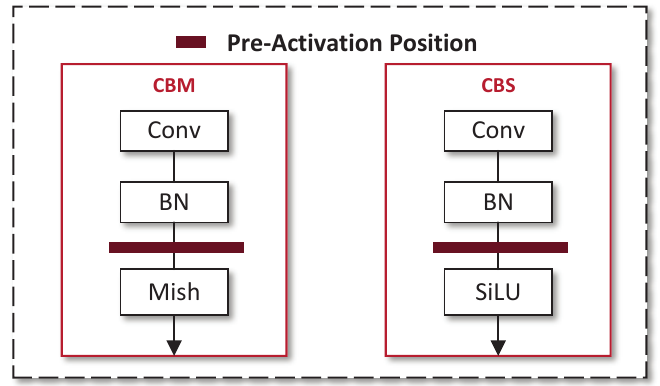
Figure 5. Distillation position before activation